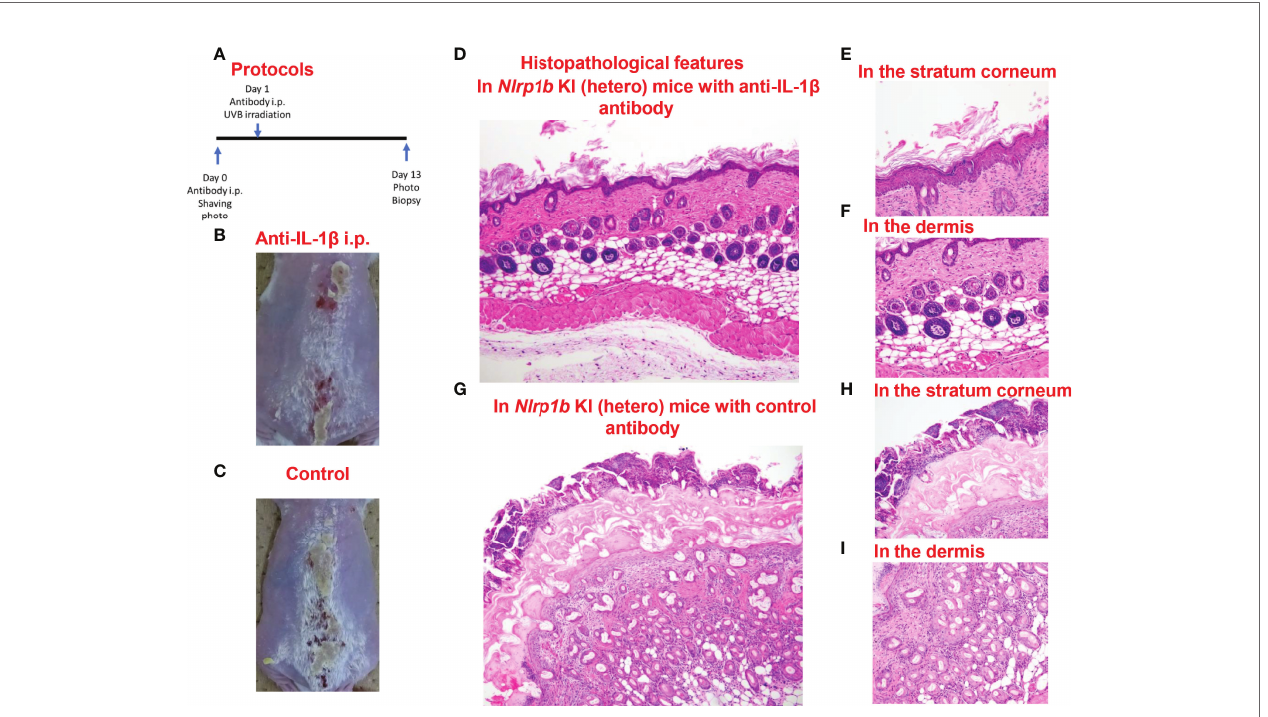
FIGURE 5 | Prevention of UVB-induced cutaneous in fl ammatory lesions in Nlrp1b KI (hetero) mice. (A) Protocols for the development of UVB-induced autoin fl ammatory skin lesions. For prevention by anti-IL-1 b antibody, Nlrp1b KI (hetero) mice were treated with the intraperitoneal (i.p.) injection of anti-IL-1 b antibody on Days 0 and 1. (B, C) The skin in fl ammation and hyperkeratosis induced by UVB irradiation were inhibited in the Nlrp1b KI (hetero) mice with anti-IL-1 b antibody treatment by i.p. administration before UVB irradiation (B) , compared with in the Nlrp1b KI (hetero) mice with control IgG antibody treatment by i.p. administration (C) . (D – F) Histopathological features of skin samples from the treated mice. In the Nlrp1b KI (hetero) mice with anti-IL-1 b antibody treatment, hyperkeratosis and in fl ammatory cell in fi ltration (D, F) are very mild, whereas in the Nlrp1b KI (hetero) mice with control IgG antibody treatment, severe hyperkeratosis with remarkable in fl ammatory cell in fi ltration in subcorneal areas and in the stratum corneum is observed (G – I) , and in fi ltration of various in fl ammatory cells in the dermis is seen (I)